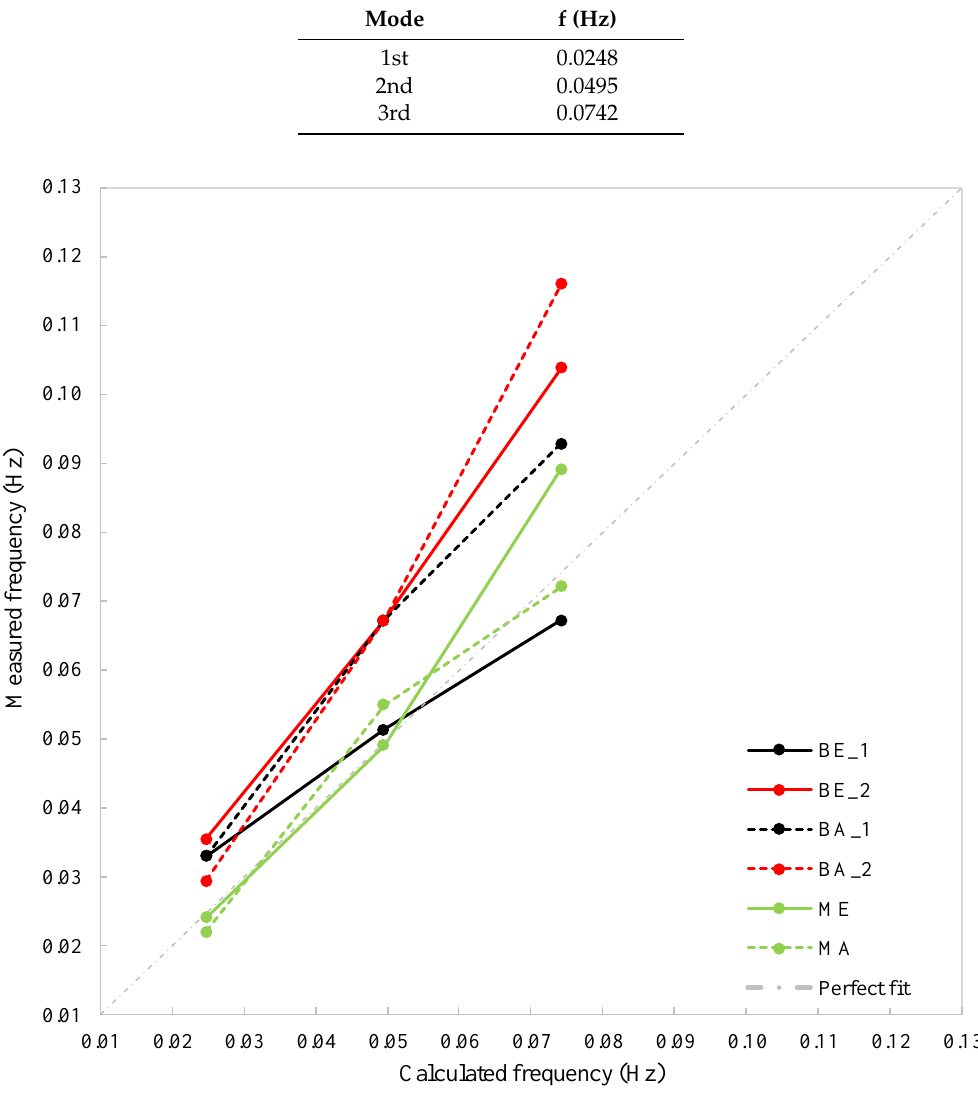
Table 7. Eigenvalues calculated for the wave flume through the formula proposed by Merian [43].